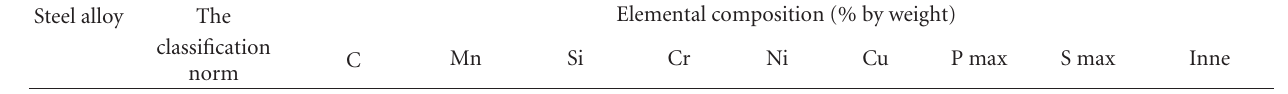
Table 1: Chemical composition of 1045 steel.